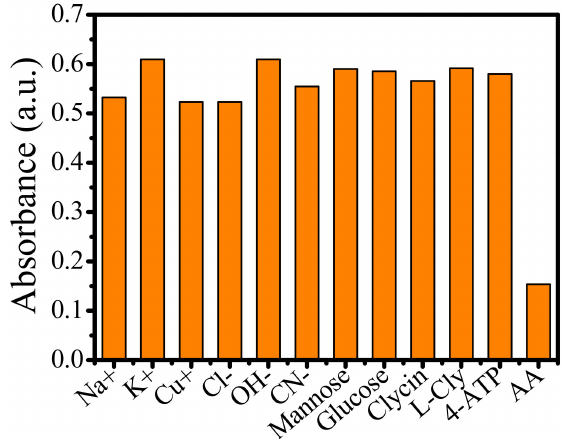
Figure 8. Absorbance intensity of the TMB–Au-tipped Pt NRs–H 2 O 2 system in response to AA and interferential substances. The concentration of AA and interferential substances was 1.0 µ